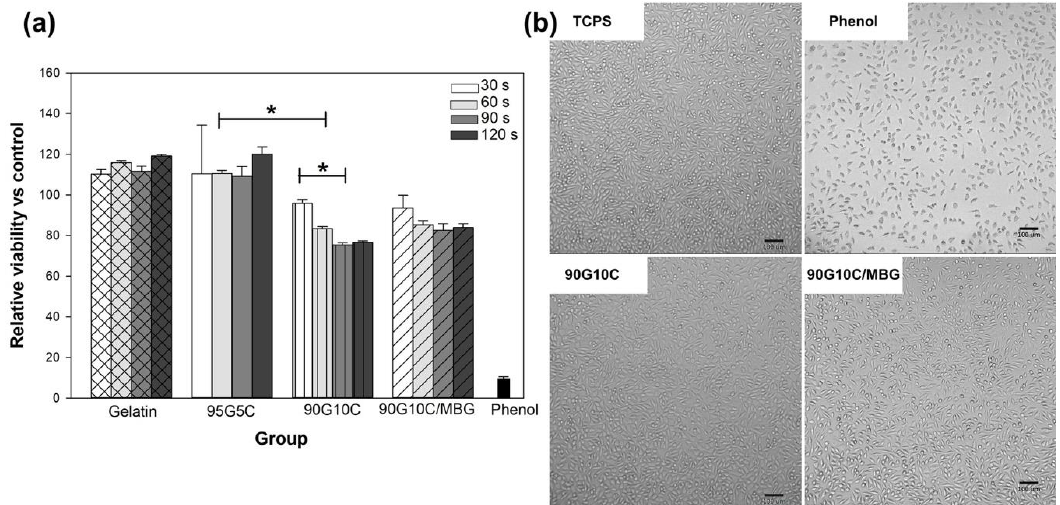
Figure 7. Cytotoxicity assay of various composites. The viability of L929 cells was determined with the WST-1 reagent after culture with various extracts for 24 h ( a ), and images of cellular morphology were taken using an inverted microscope ( b ). Data are presented as the mean ± SD (n = 9) and were analyzed using the nonparametric Kruskal–Wallis H-test. Differences of p < 0.05 were considered statistically significant. (*) denotes a significant difference (p < 0.05)